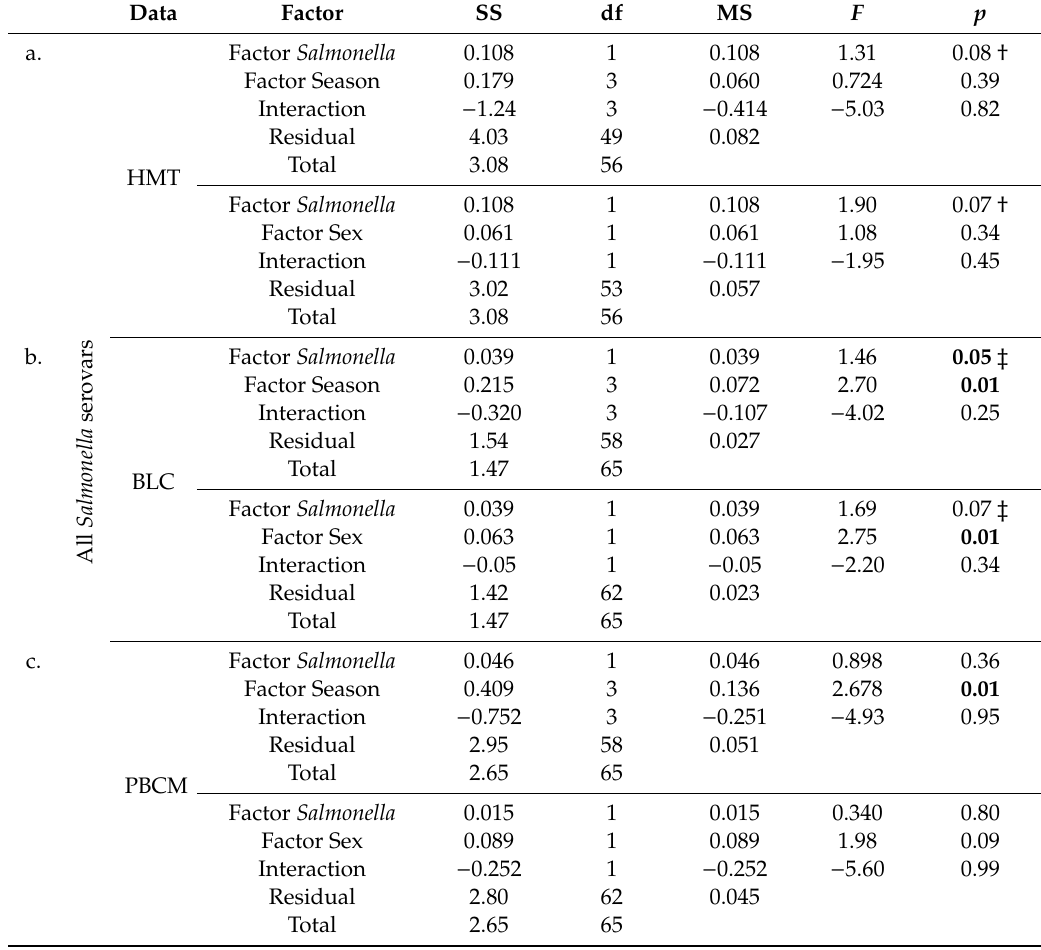
Table 3. Two-way permutational multivariate analysis of variance (PERMANOVA) of selected HMT variables (a) (corrected WBC, RBC, HGB, PCV, and absolute counts for leukocytes obtained with a manual di ff erential on a blood smear), BLC analytes (b) (ALP, ALT, AST, CK, PROT, ALB, CALC, PHOSP, CHOL, BILT, GLUC, CREAT, UREA, and vitamin E), and PBCM (c), for quokkas that were positive and negative to any Salmonella serovar, with season and sex as independent factors. Bray–Curtis similarity index, permutations N = 9999. Only two independent factors could be tested simultaneously, and thus the presence of Salmonella was tested first with season, and then secondly with sex of the animal. HMT = haematology, BLC = blood chemistry, PBCM = peripheral blood cell morphology. Data